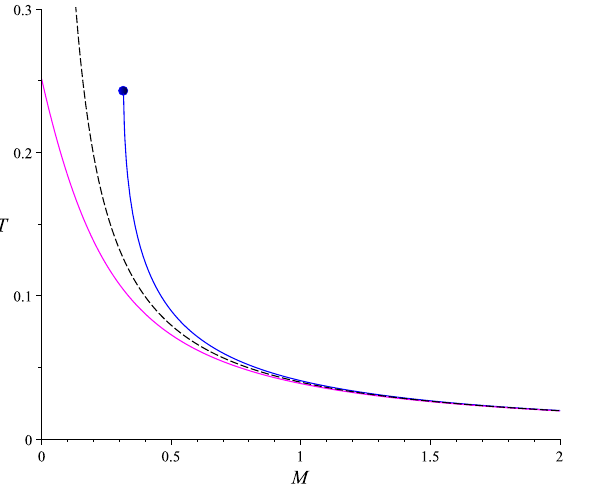
Figure 1 . The various Hawking temperature of an asymptotically (cid:13)at Schwarzschild black hole. The usual Hawking temperature corresponds to the middle dashed curve, which diverges as M ! 0. The in(cid:12)nity is \cured" with GUP correction: if (cid:11) > 0, the temperature curve terminates at around p M (cid:24) (cid:11)M p , as shown by the right-most curve. If (cid:11) < 0, GUP correction no longer imposes a lower bound on the black hole size. This corresponds to the left-most curve: the temperature remains (cid:12)nite as the black hole shrinks down to zero